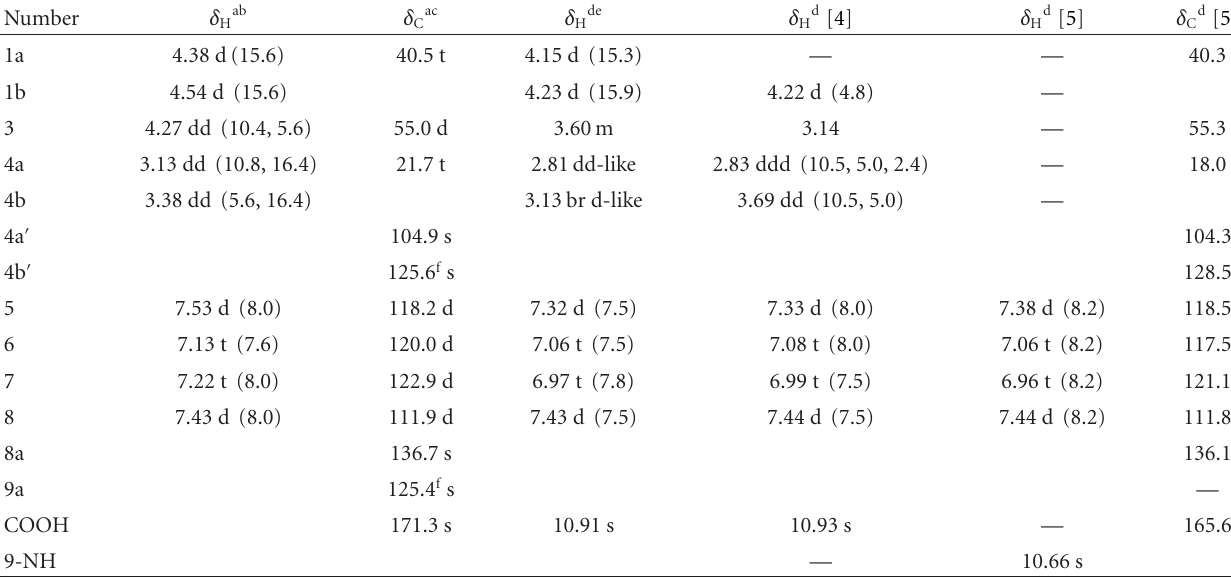
Table 1: 1 H and 13 C NMR spectroscopic data for compound 1 .